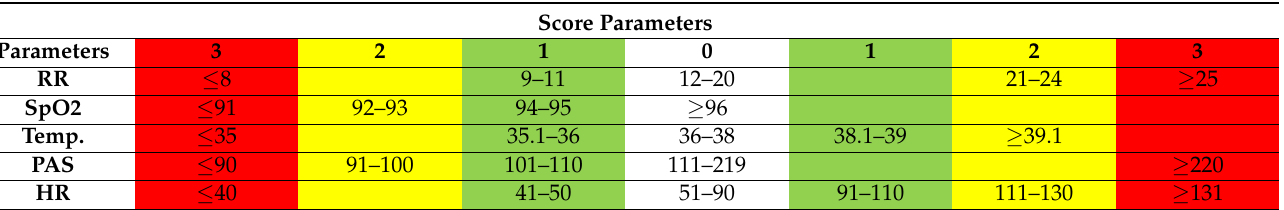
Table 2. Score parameters and colour